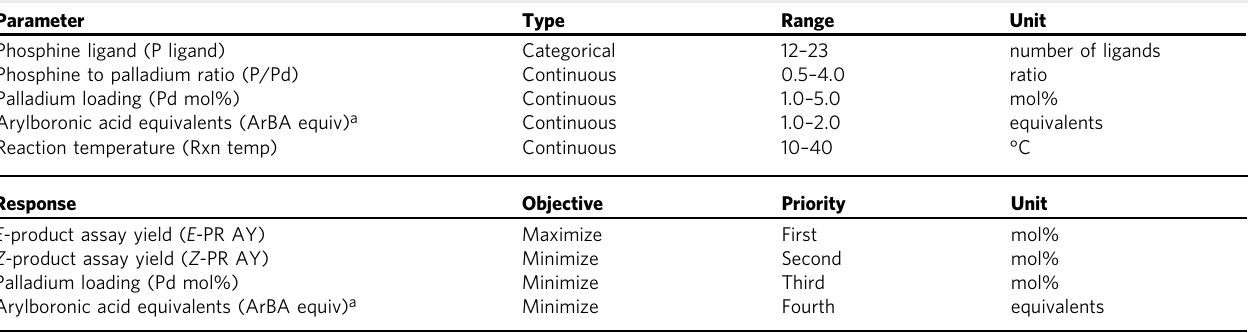
Table 1 Process parameters and optimization